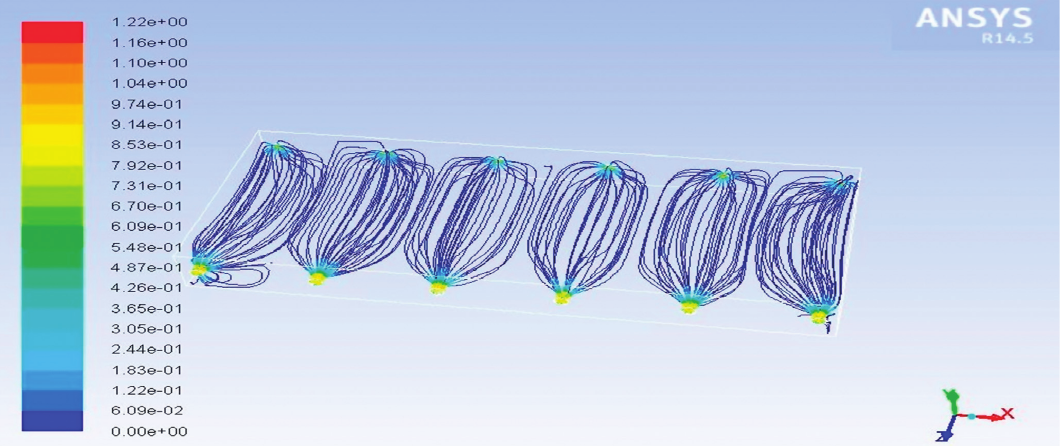
Figure 15: Velocity movement of contour inside the solar.